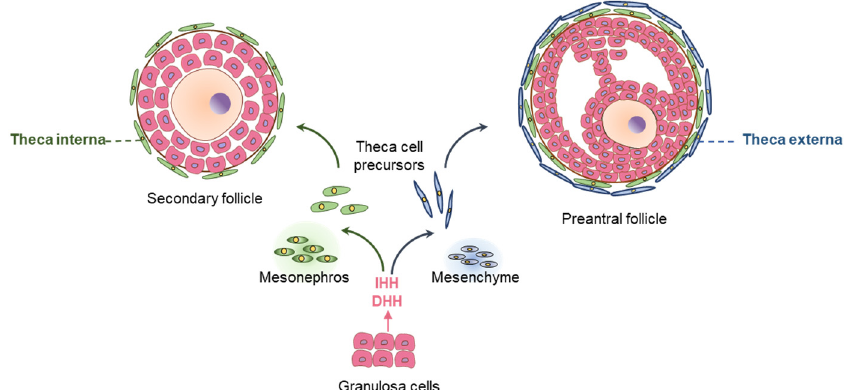
Figure 9. The role of hedgehog signaling in ovarian folliculogenesis. DHH and IHH are expressed in granulosa cells (GCs) of activated ovarian follicles. The major role of HH signaling in ovary involves development and differentiation of theca cells (TCs). Loss of both DHH and IHH in GCs leads to lack of TC development of both mesonephros or mesenchyme origin, associated with ineffective steroidogenesis, and infertility due to failure of ovulation.